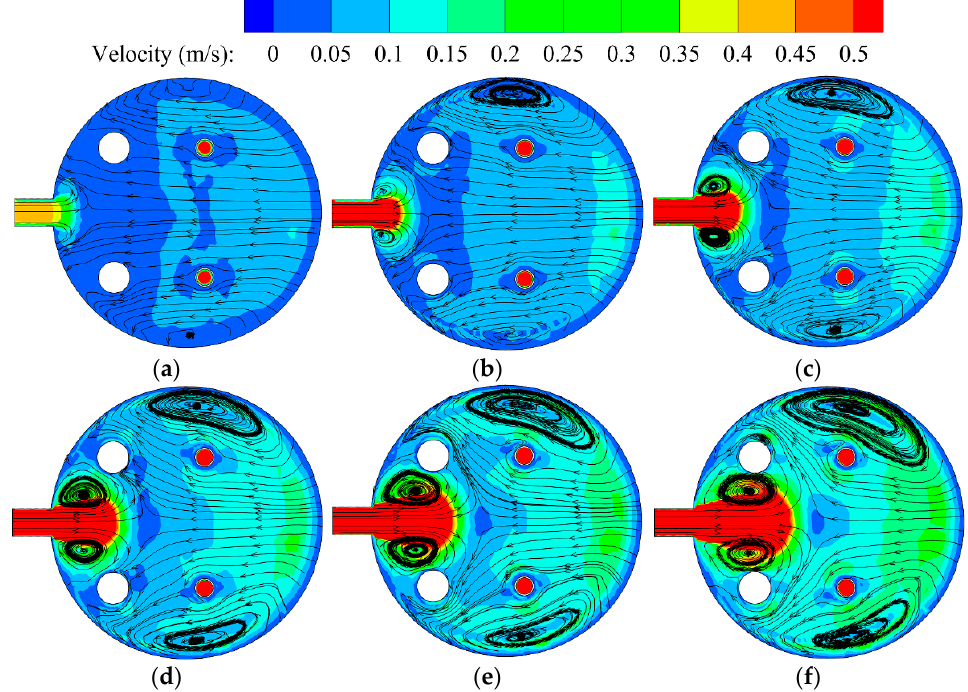
Figure 8. Cross-section A2 flow velocity and streamline distribution. ( a ) 0.33 Q d , ( b ) 0.67 Q d , ( c ) 1.00 Q d , ( d ) 1.33 Q d , ( e ) 1.67 Q d , and ( f ) 2.00 Q d .